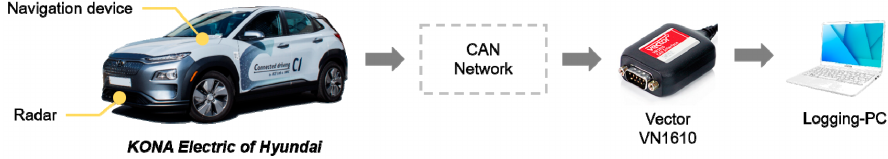
Figure 22. Test vehicle, sensors and logging system used by